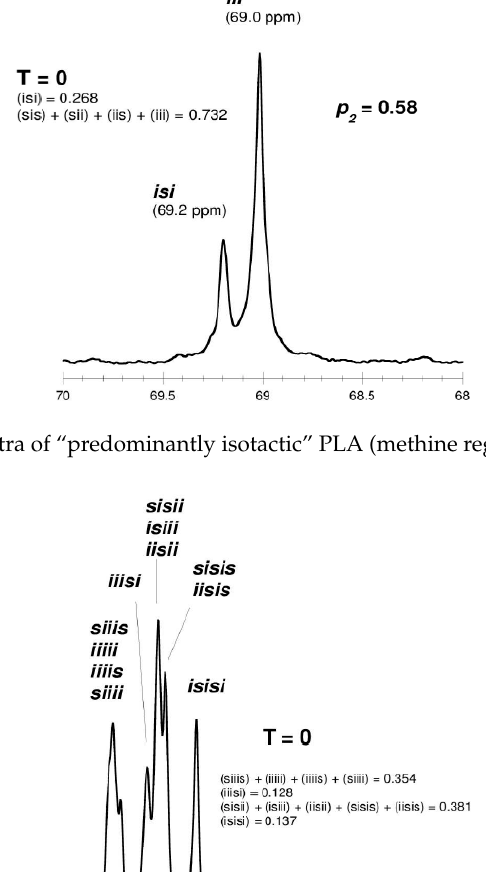
Figure 3. 13 C-NMR spectra of “predominantly isotactic” PLA (carbonyl region) ( p 2 = 0.58, PLA 25 ).